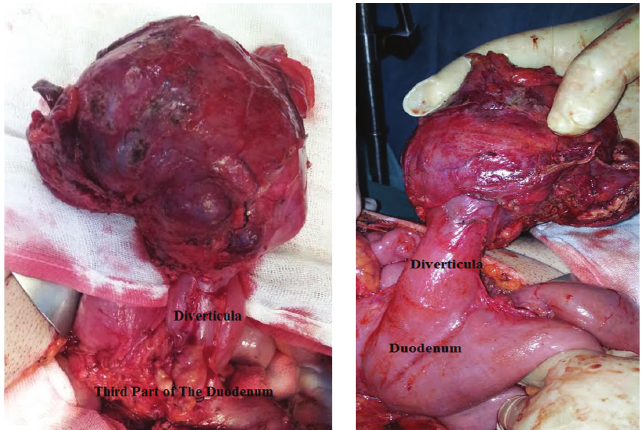
Figure 1: The macroscopic view of the mass.